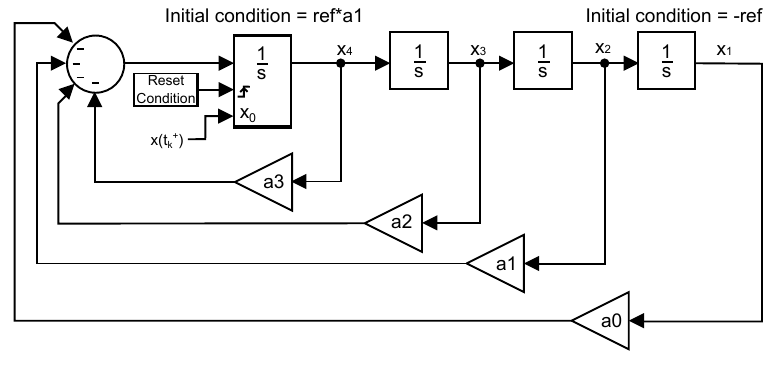
Figure 20. Canonical form of the autonomous